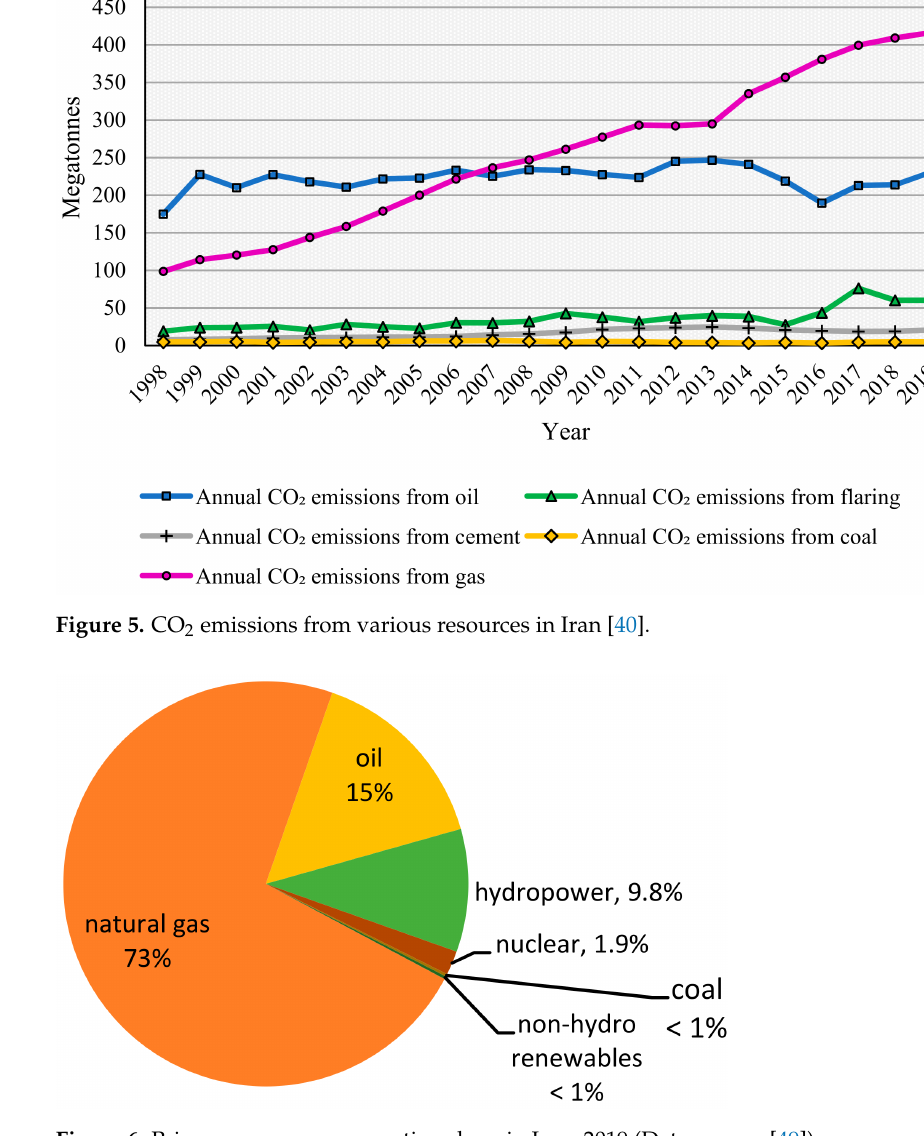
Figure 6. Primary energy consumption share in Iran, 2019 (Data source: